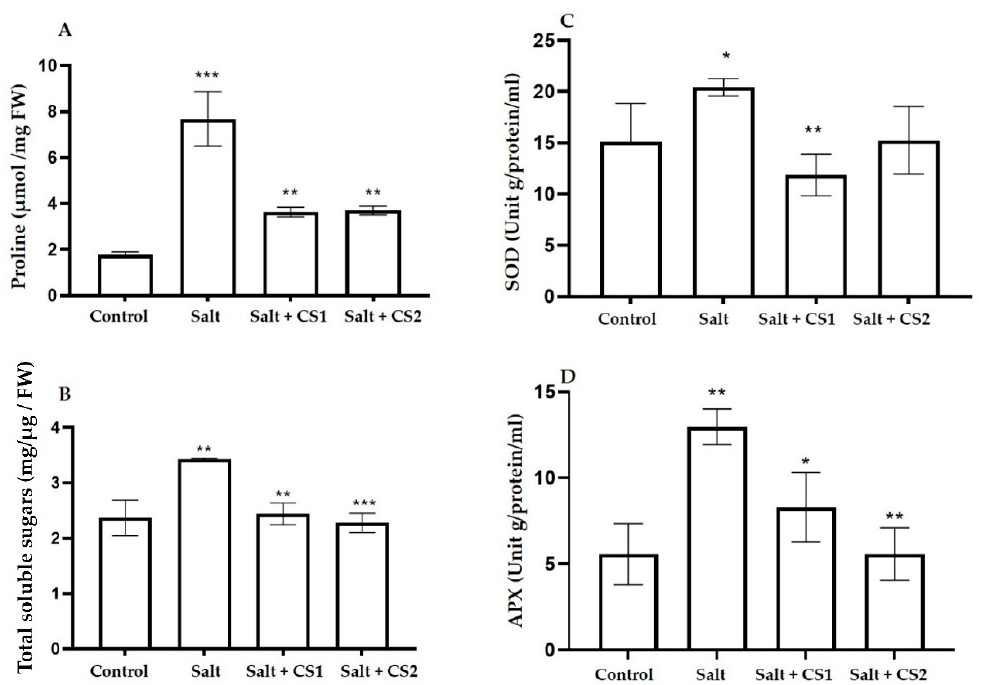
Figure 6. Exogenous chitosan (CS) reduced osmolyte accumulation and enzyme activities under salt stress in sorghum. ( A ) Proline content, ( B ) total soluble sugars content, ( C ) superoxide dismutase (SOD), and ( D ) ascorbate peroxidase (APX) in control (0 mM NaCl) and salt-treated (300 mM NaCl) plants supplemented with chitosan (CS1 = 0.25 mg/mL and CS2 = 0.5 mg/mL). Error bars represent the SD calculated from three biological replicates. Statistical significance between the control and treated seedlings was determined using a two-way ANOVA conducted on GraphPad Prism 9.2.0, shown as *** = p ≤ 0.001, ** = p ≤ 0.01, and * = p ≤ 0.05.